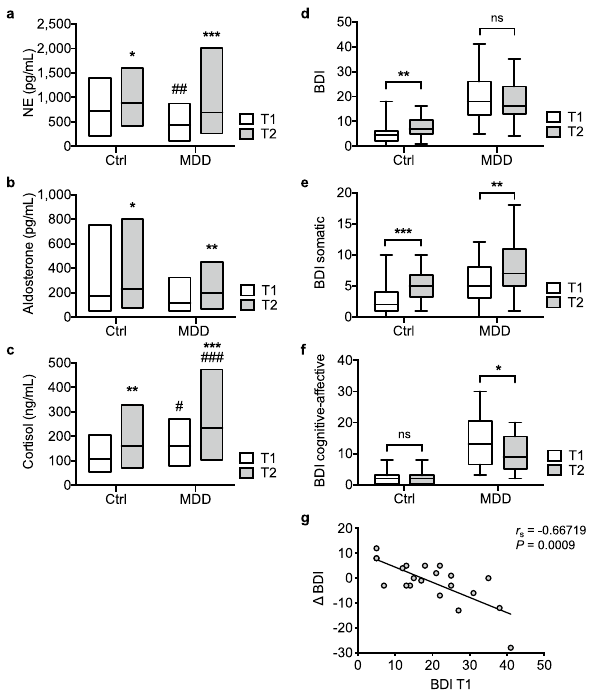
Figure 1. Effect of fasting on serum levels of stress hormones and BDI-2 scores in Ctrl and MDD. Box plots ( a – c ) depict mean with minimum and maximum values of norepinephrine (NE, a ), aldosterone ( b ) and cortisol ( c ) before (T1) and after (T2) fasting in Ctrl and MDD. RM two-way ANOVA followed by Sidak’s multiple comparison test was used to compute adjusted P -values. Box plots ( d – f ) depict median and interquartile range and whiskers show minimum and maximum values of BDI-2 score ( d ), BDI-2 somatic sub-score ( e ) or BDI-2 cognitive-affective sub-score ( f ). P -values were computed using Wilcoxon matched-pairs signed rank test followed by Holm-Sidak test to correct for multiple comparisons. Only time-point differences were assessed (T1 versus T2) while potential differences between groups (Ctrl versus MDD) were not tested. Spearman correlation was used to assess association of BDI T1 and ΔBDI ( g ) in the MDD group. Resulting two-tailed P - and r s -values are depicted. **** P < .0001, *** P < .001, ** P < .01, * P < .05 versus corresponding T1; #### P < .0001, ### P < .001, ## P < .01 versus corresponding Ctrl. Ctrl: N = 28, MDD: N =